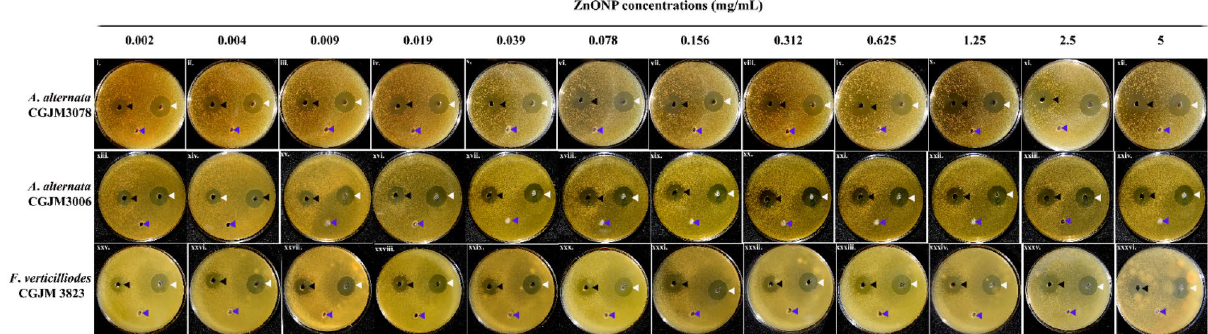
Figure 6. Plates representing the inhibition zones across a concentration range of ZnONPs against the fungal strains Alternaria alternata CGJM3078 (i–xii), A. alternata CGJM3006 (xiii–xxiv) and Fusarium verticilliodes